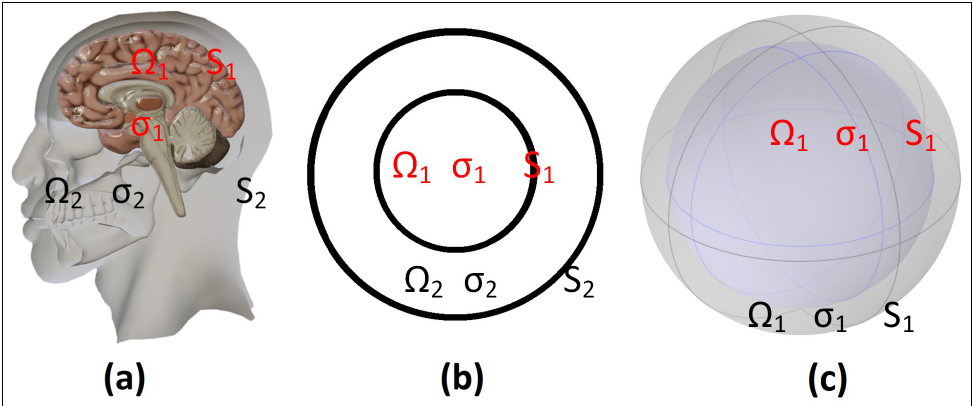
Figure 3. ( a ) Two regions model in Figure 2c chosen for representation with two simple regions; ( b ) 2D representation of the model in ( a ) with two concentric circles representing regions 1 and 2; ( c ) 3D representation of the model in ( a ) with concentric